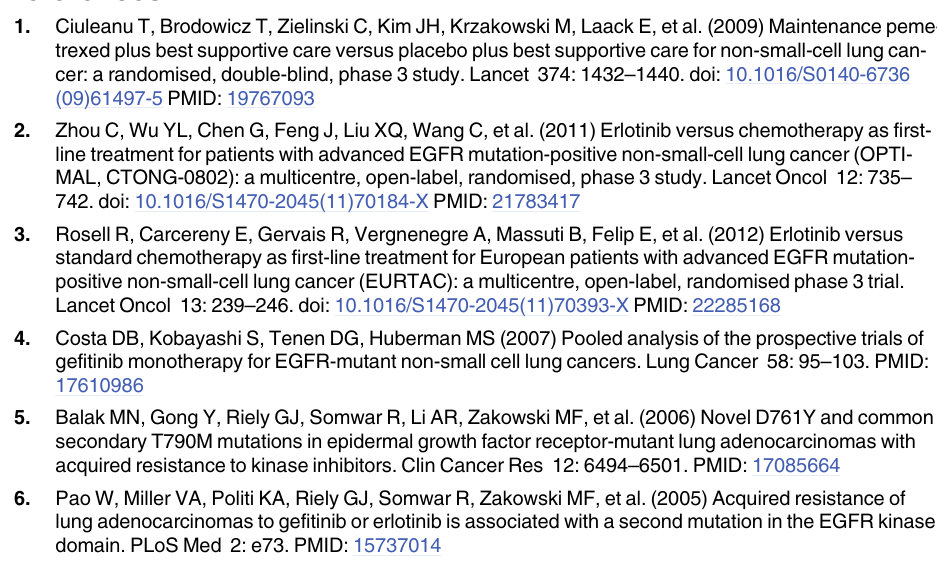
S3 Table. The raw date of the proliferation effects after treatment with different concentra- tion of Gefitinib single agent, SANT-1 single agent or the combination of Gefitinib and SANT-1 on A549 cells analyzed by factorial analysis. S4 Table. The effects of proliferation after treatment with different concentration of Gefiti- nib single agent, SANT-1 single agent or the combination of Gefitinib and SANT-1 on A549 cells. S5 Table. The raw date of the proliferation effects after treatment with different concentra- tion of Gefitinib single agent, SANT-1 single agent or the combination of Gefitinib and SANT-1 on H1975 cells analyzed by factorial analysis. S6 Table. The effects of proliferation after treatment with different concentration of Gefiti- nib single agent, SANT-1 single agent or the combination of Gefitinib and SANT-1 on H1975